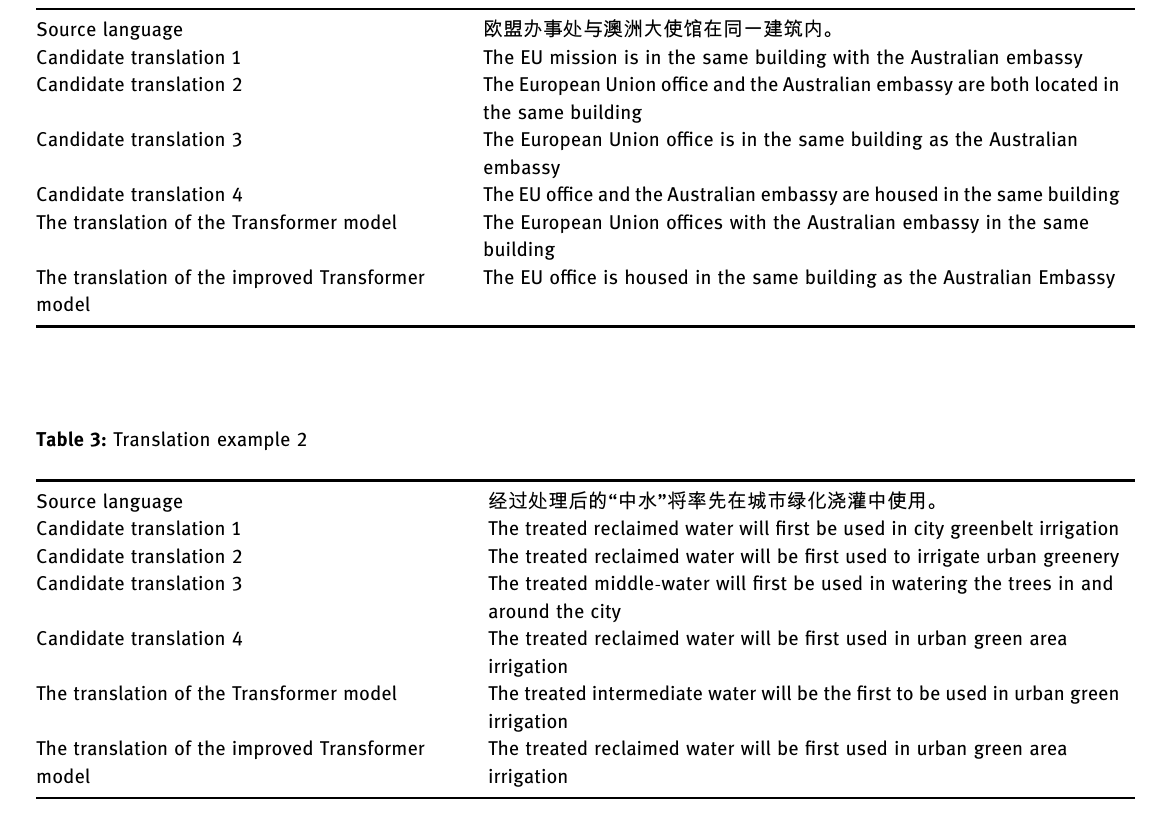
Table 2: Translation example 1 Source language